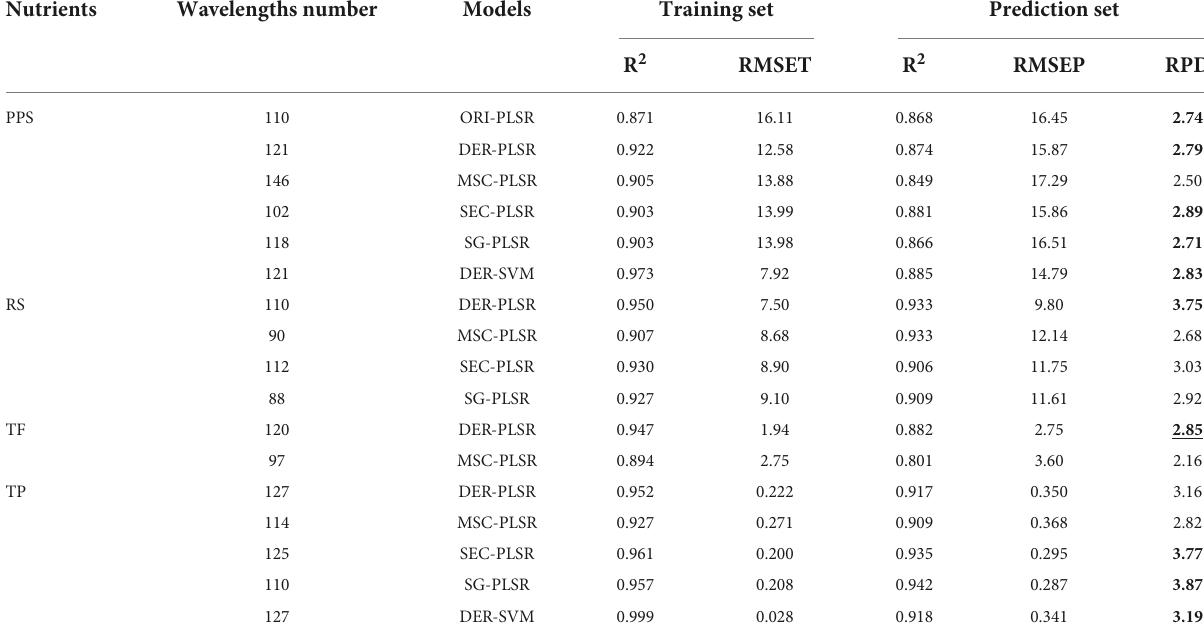
TABLE 2 Nutrient content prediction based on the effective wavelengths selected by the VISSA method. Nutrients